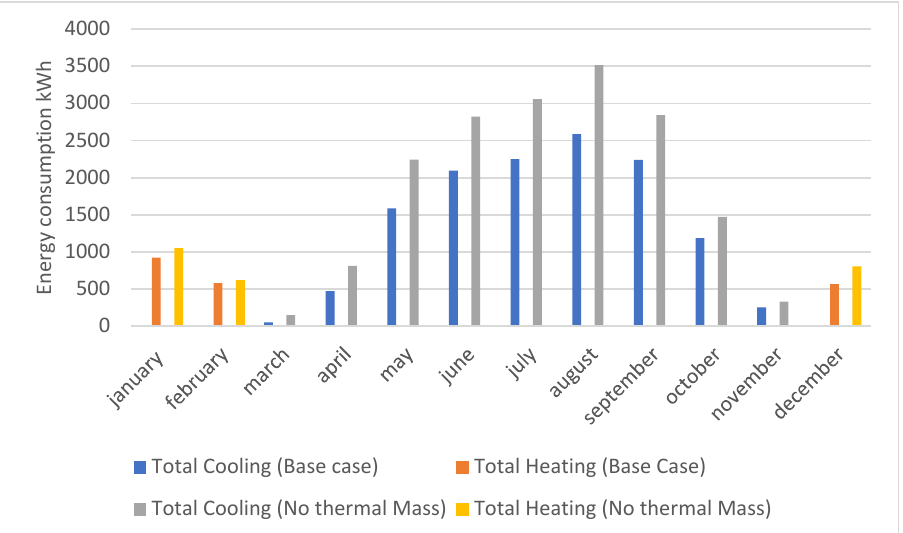
Figure 21. The annual energy consumption for Case 1 with modified thermal mass wall to imitate the contemporary house’s exterior wall structure.